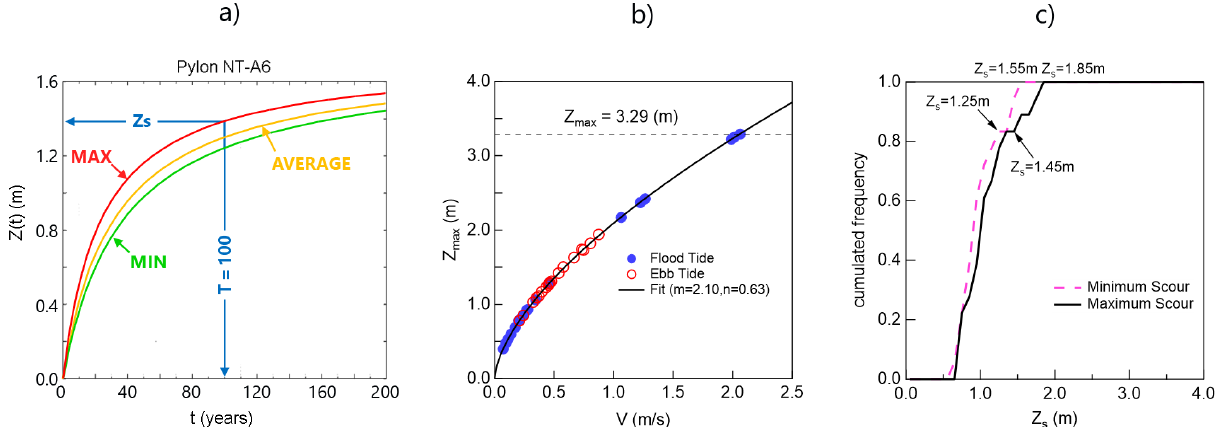
Figure 10. ( a ) Erosion curves Z ( t ) obtained by considering different erosion rates, ˙ r min , ˙ r ave , ˙ r max , for one of the piles of NT (pile A6). The erosion depth Z s was indicated for reference. ( b ) Parameter Z max involved in Equation (19) versus mean flow velocity (cid:107) (cid:126) V (cid:107) at each pile ( (cid:126) V is the velocity obtained from OpenFoam). The fitting curve is given by Equation (21). ( c ) Cumulated frequency distribution of Z s for its minimum and maximum range of values. Some referential points were included as a guide to the eye. Figures adapted from